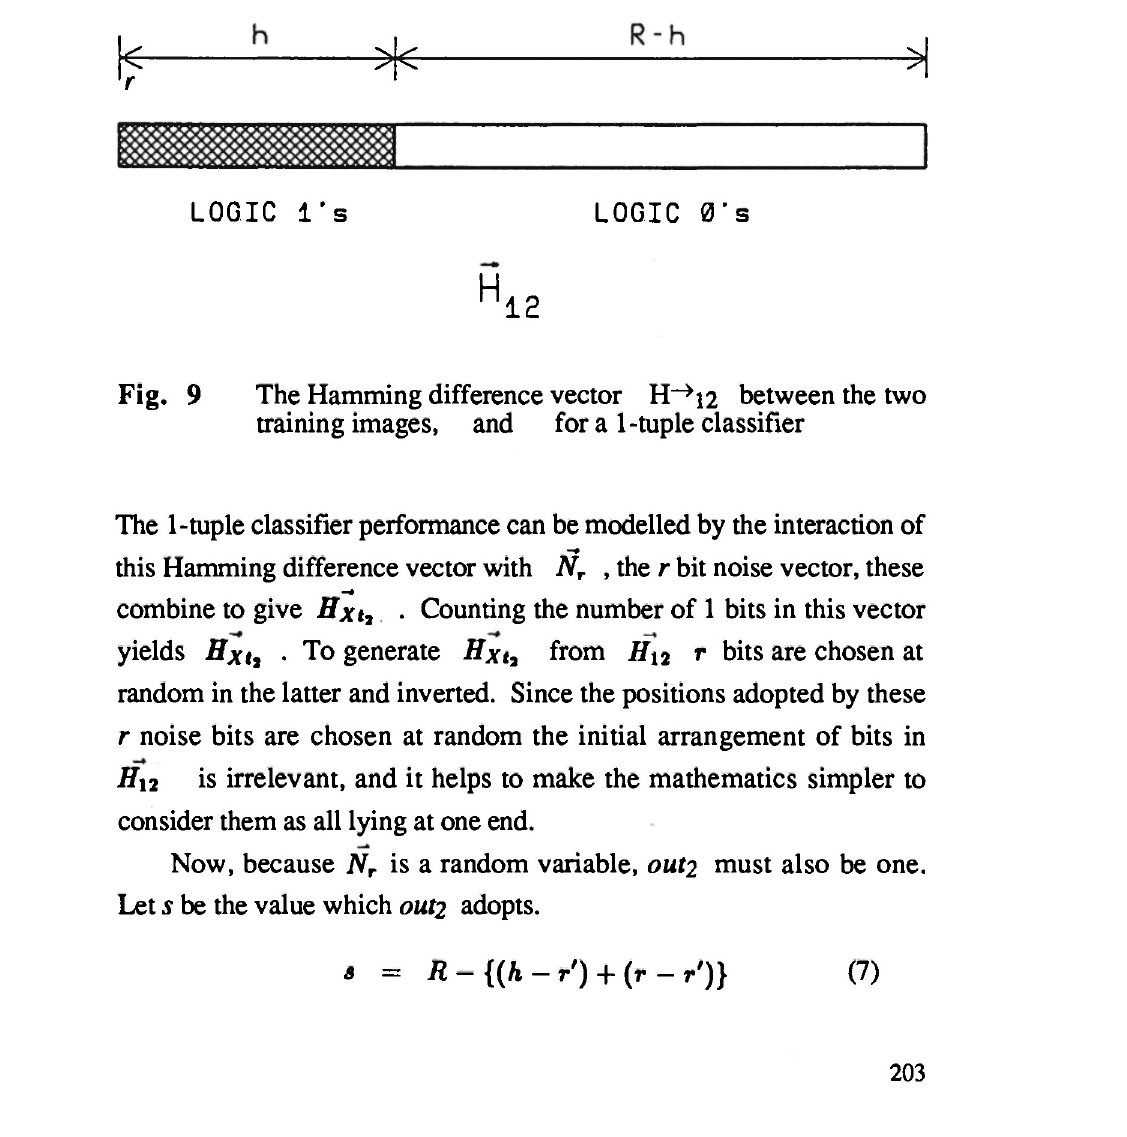
Fig. 9 The Hamming difference vector H ^ i2 between the two training images, and for a 1-tuple classifier